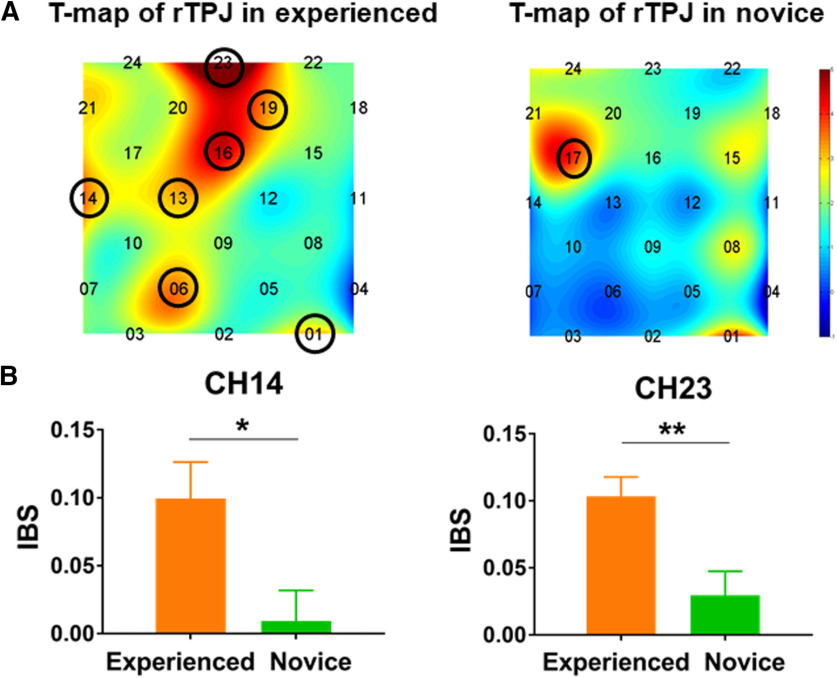
Comparison of the IBS achieved in the two groups. A, CH1, CH6, CH13, CH14, CH16, CH19, and CH23 in the experienced counselor group and CH17 in the novice counselor group showed significant synchronization (FDR corrected). B, IBS was significantly larger on CH14 and CH23 in the experienced counselor group compared with that in the novice counselor group (period = 22.24–41.98 s); *p < 0.05, **p < 0.01. Error bars indicate SEs.